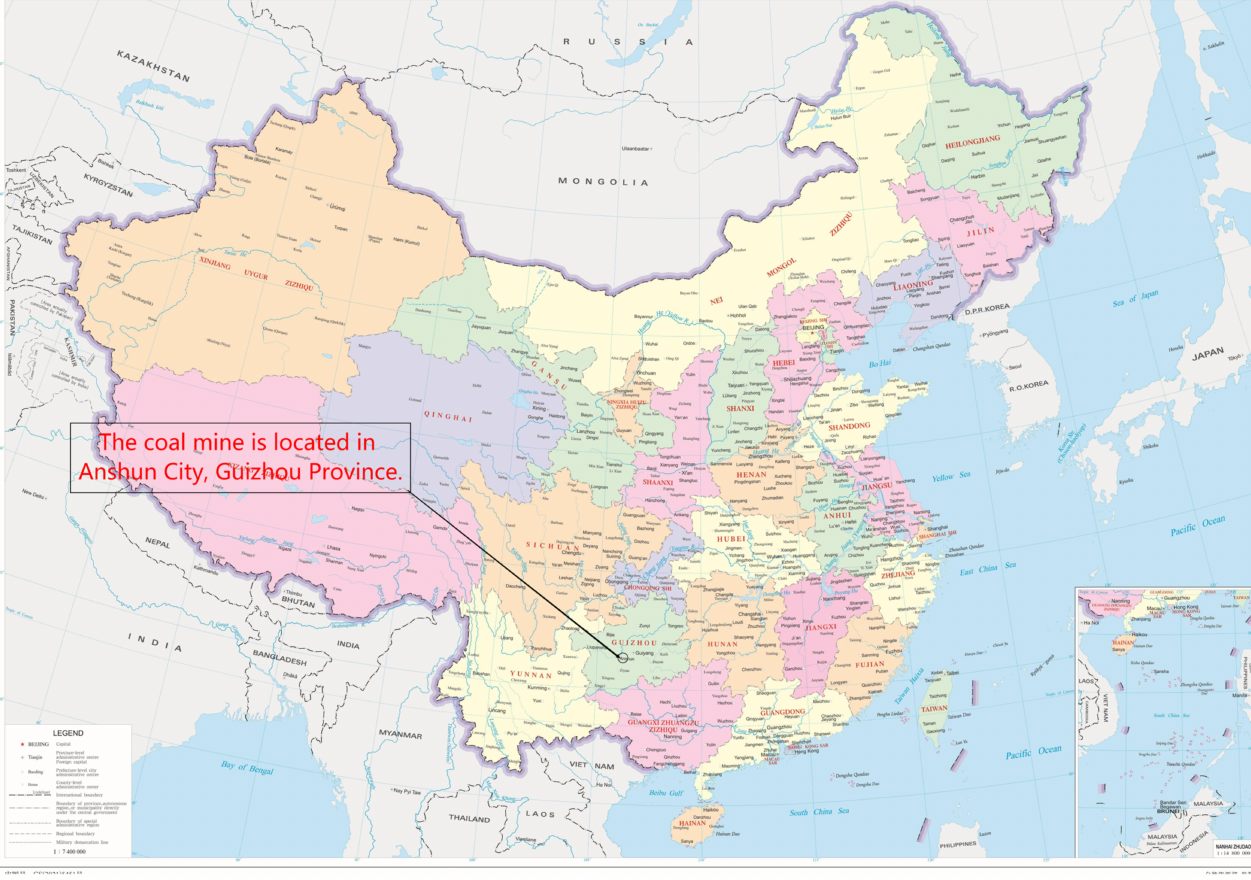
Figure 6. Comprehensive standard cloud model for total